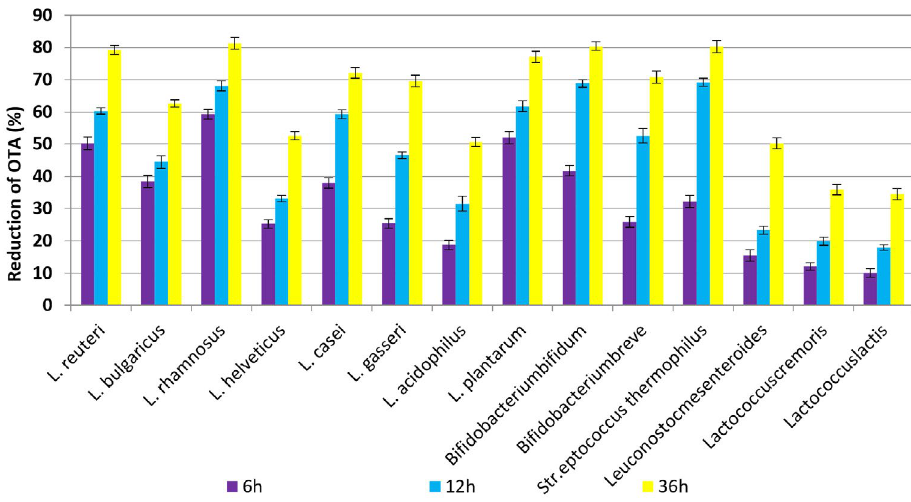
Fig. 3. The percentages of reduction OTA after incubation for 6h, 12h and 36h at 37°C with LAB Table 3. ANOVA for effect of incubation time and type of LAB strains on reduction OTA Source